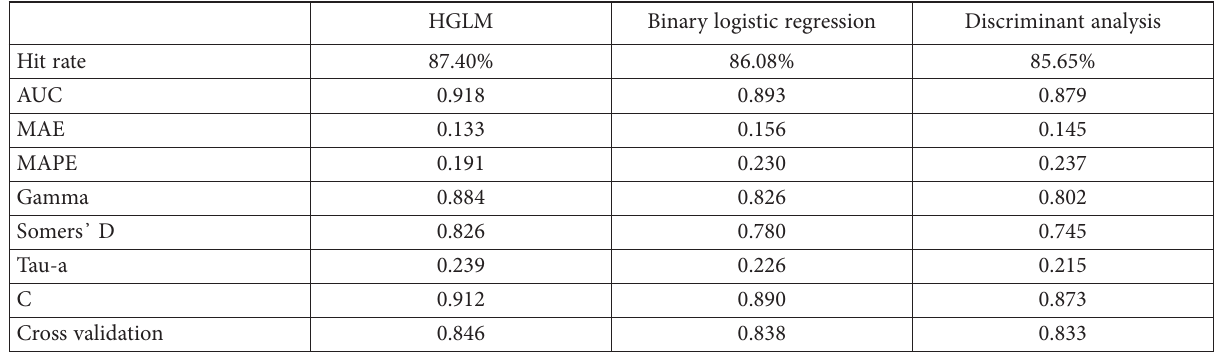
Table 4. Comparison of three